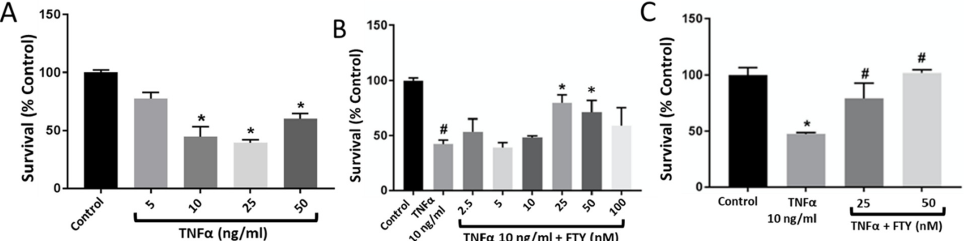
Figure 1. Dose-response effect of TNF α treatment on R28 cell survival and its reversal by co-treatment with fingolimod. ( A ) Neuronal damage was induced by treating R28 cells with various doses of TNF α for 24 h assessed by Trypan blue method. TNF α at 10ng/mL showed a marked reduction in cell survival and was chosen as the effective dose for further analysis. [ n = 3; * p < 0.05 vs. dose 0]. ( B ) Cells were pre-treated with different doses of FTY, followed by TNF α (10 ng/mL), and cell survival was assessed at 24 h. Bar graph showing the effect of 25, 50, and 100 nM FTY on improving the rate of R28 cell survival [# p < 0.005 vs. Con; * p < 0.05 vs. TNF α ]. ( C ) Bar graph indicating 25 nM as the optimal dose of FTY in protecting R28 cells from TNF α -induced injury in vitro [ n = 3; * p < 0.001 vs. Con; # p < 0.01 vs. TNF α ].